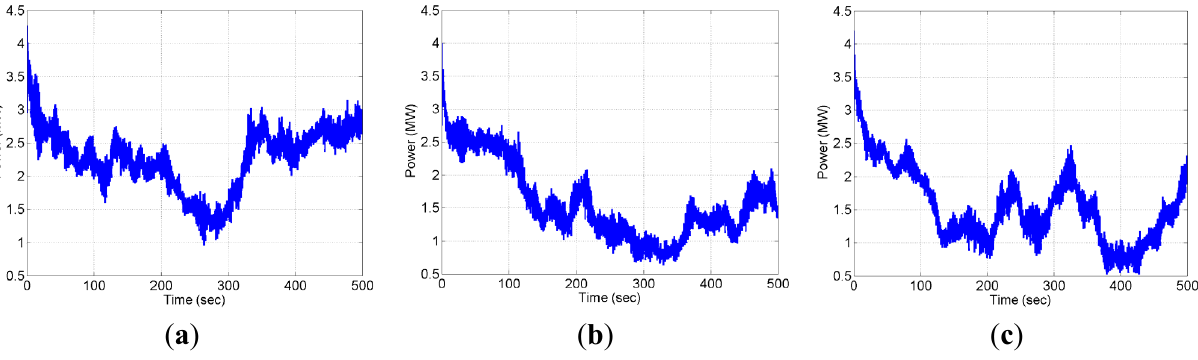
Figure 16. Time series of turbine power (5-Turbine Wind Farm, V Wind = 8 m/s). ( a ) Turbine 1; ( b ) Turbine 2; ( c ) Turbine